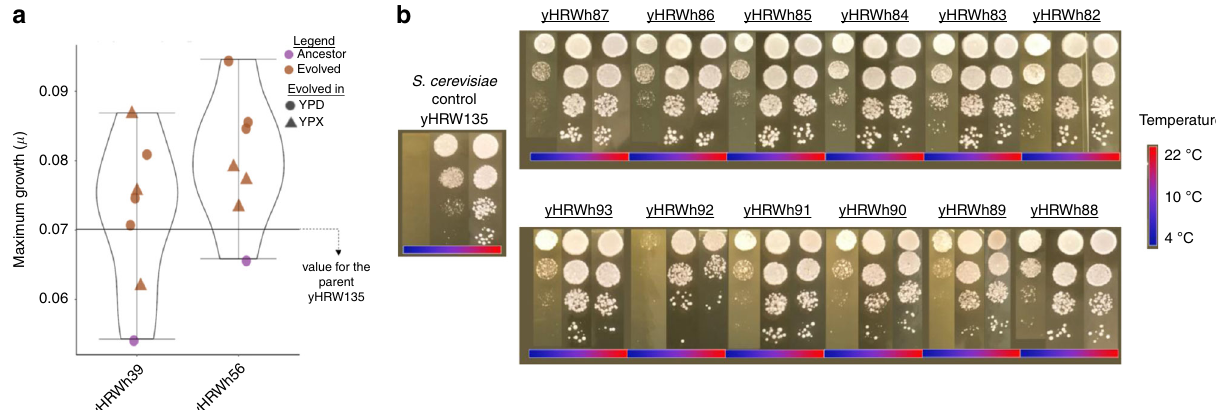
Fig. 5 Trait combination and improvement by adaptive laboratory evolution. a Box plots for the individual evolved colonies isolated from YPX or YPD plates after ALE and their synthetic hybrid ancestors. Kinetic parameters were tested in 3 ml YPX on a rotating culture wheel, identically to how they were evolved for 80 generations. The average values ( n = 6) of maximum speci fi c growth rates ( µ , de fi ned as (ln( OD2 ) − ln( OD1 ))/( T2 − T1 )) for the S. cerevisiae reference strain (black line, yHRW135 was derived from yHRW134 by plasmid loss), ancestor six-species hybrids (purple dots), and evolved six-species hybrids (brown dots) are shown (Supplementary Data 5). Different shapes indicate the media in which the synthetic six-species hybrids were evolved. Additional kinetic parameters from microtiter plate experiments performed on evolved populations are shown in Supplementary Fig. 6 and Supplementary Data 6. Median values are represented by a horizontal line inside the box, and the upper and lower whiskers represent the highest and lowest values of the 1.5 × IQR (interquartile range), respectively. b Spot tests for three temperatures (22, 10, and 4 °C) are displayed for the evolved strains and the S. cerevisiae reference strain yHRW135. Evolved six-species hybrids retained the ability to grow at 4 °C, a trait not possessed by S. cerevisiae , despite the fact that it was not selected during ALE. Source data are provided at